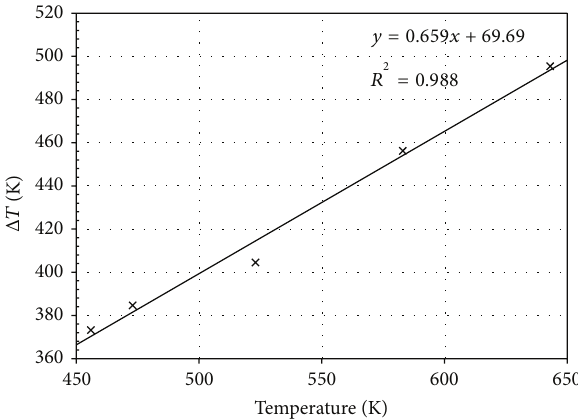
Figure 9: Δ𝑇 at different solder